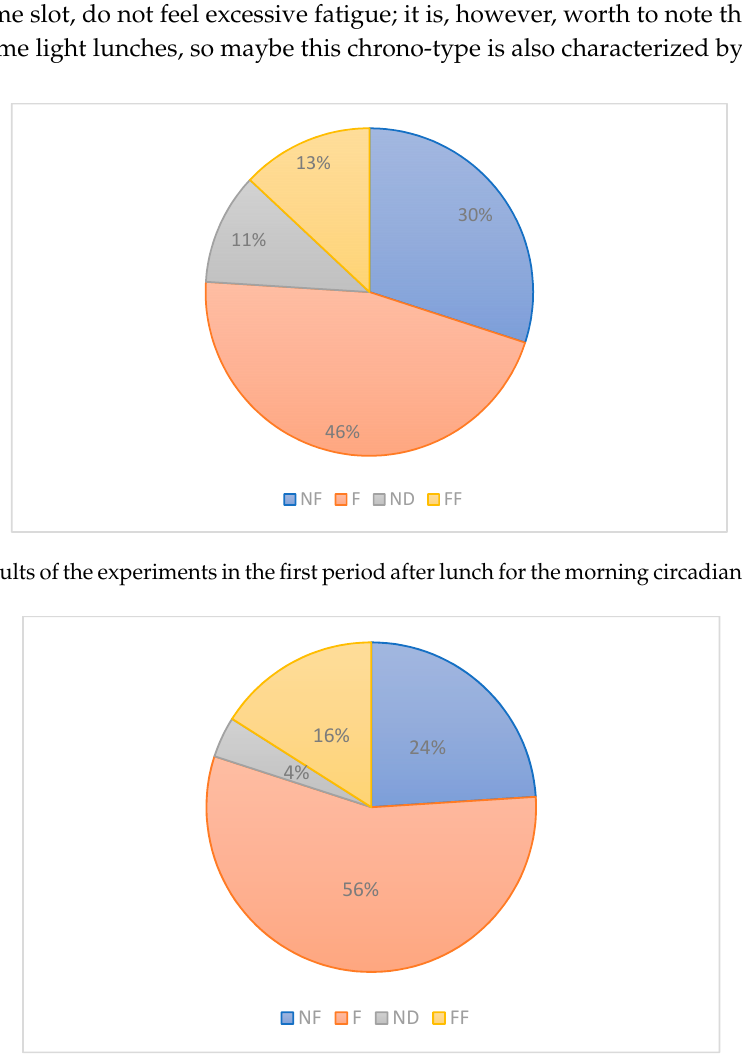
Figure 7. Results of the experiments in the afternoon for the morning circadian chrono-type.